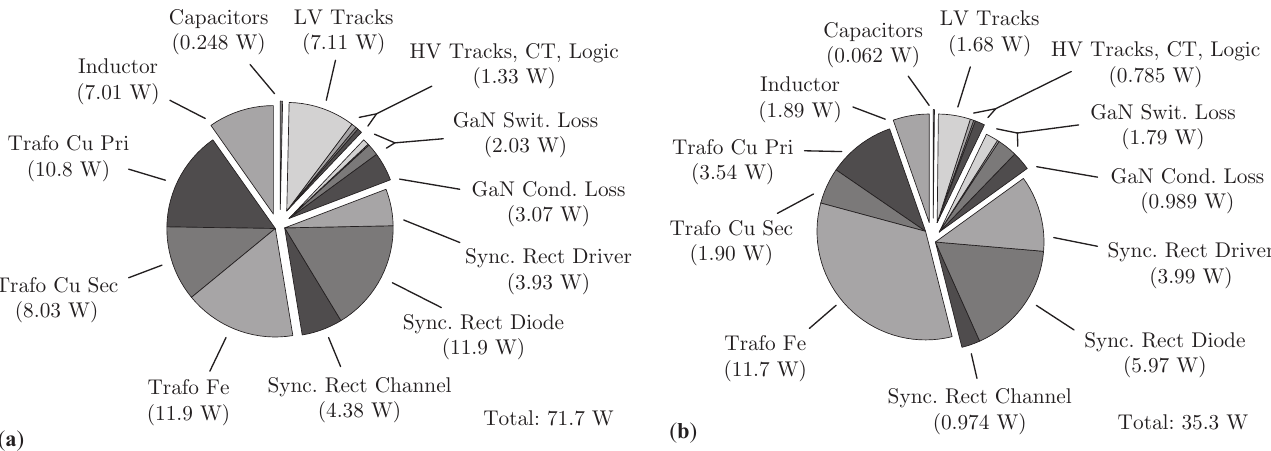
Figure 13. DC/DC calculated and electrically-measured efficiencies from input ( v dc = 300V,400V) to output ( V o = 12V) at different load conditions and two input voltages, including all loss components.